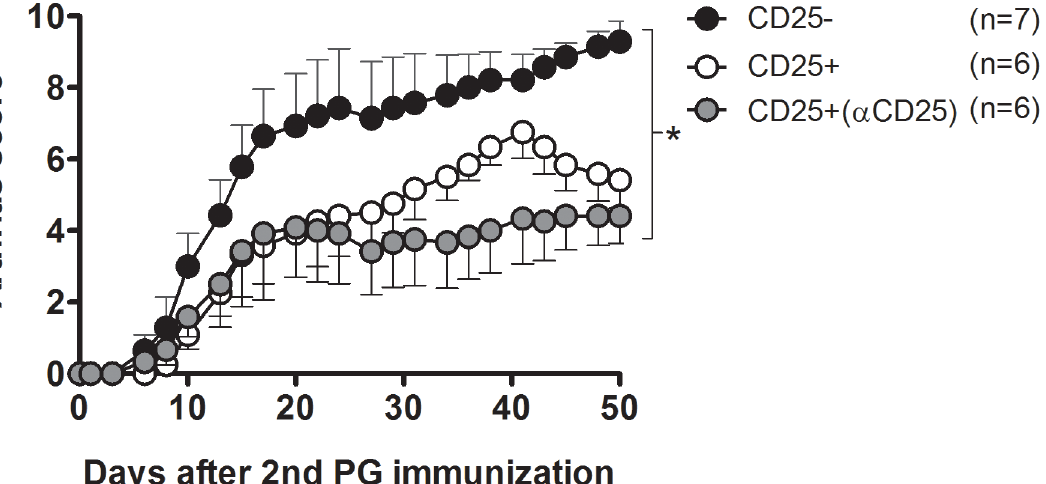
Fig 4. Adoptive transfer of B29-induced Tregs reduces inflammation in a mouse model of rheumatoid arthritis. Mean arthritis scores of recipient mice after adoptive transfer of CD4 + CD25 - cells or CD4 + CD25 + cells from B29-immunized donors (injected with PBS 7 days prior to B29 immunization), or mice receiving CD4 + CD25 + cells from B29-immunized donors injected with anti-CD25 antibody 7 days prior to immunization (depicted as CD25+ α CD25). Recipient animals (n = 6 – 7 mice per group) received 3x10 5 cells i.p. one day prior to the second PG immunization. Clinical scores were assessed over time and are depicted as the mean of the group ( ± s.e.m.). Data shown are representative for 2 experiments. P values are from a two-way ANOVA (all time points) followed by Bonferroni post hoc comparison. * P <